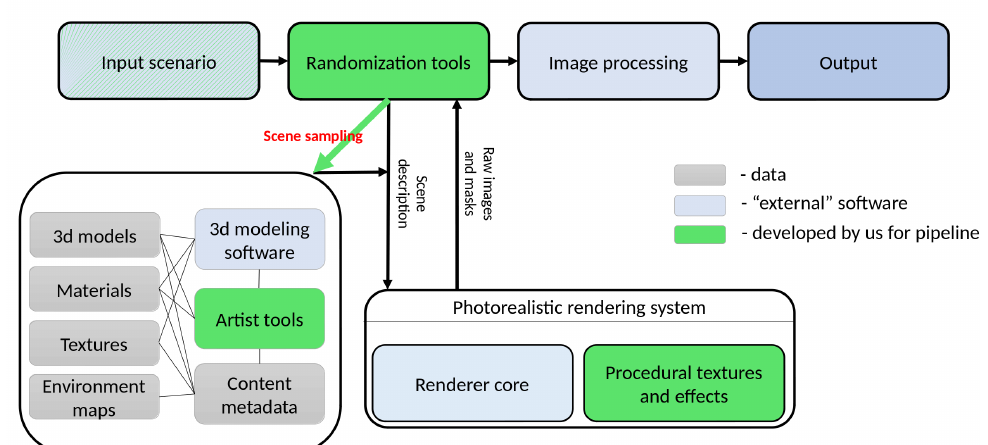
Figure 2. Proposed architecture of a synthetic data generation system. The green boxes represent the custom parts of the pipeline that we have developed in this work. The green arrow “Scene sampling” illustrates the process of scene rendering from a set of input random parameters that we discuss in Section